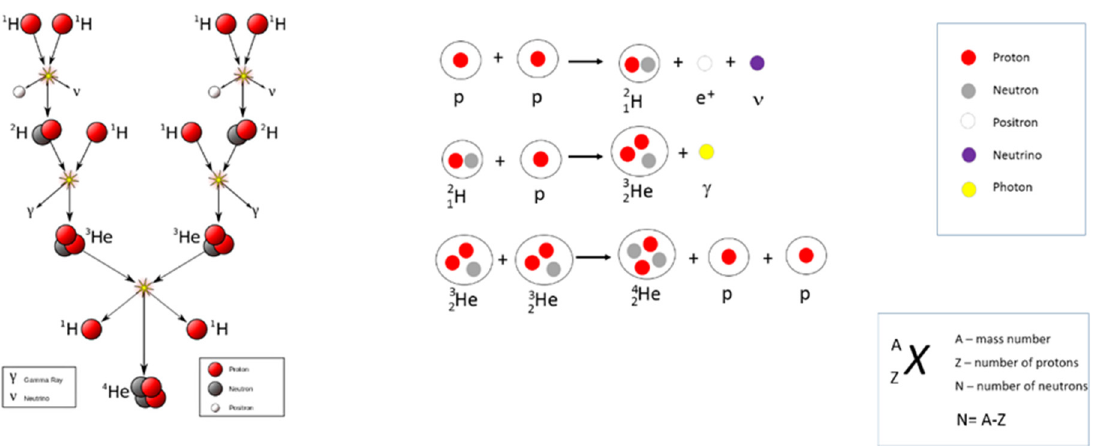
Figure 2. Fusion reaction scheme for the transformation of hydrogen into helium.